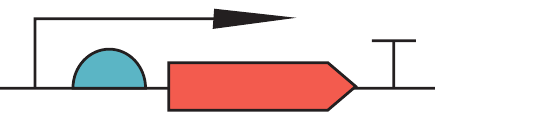
Figure 12: Example of incorrect glyph overlap: promoter (arrow) does not overlap in sequence with the ribosome entry site and CDS, so SHOULD NOT overlap visually with them. 5. Nucleic acid features that overlap in their locations SHOULD have glyphs whose bounding boxes overlap. Overlap size MAY be used to indicate relative position. Examples are provided in Figure 13.